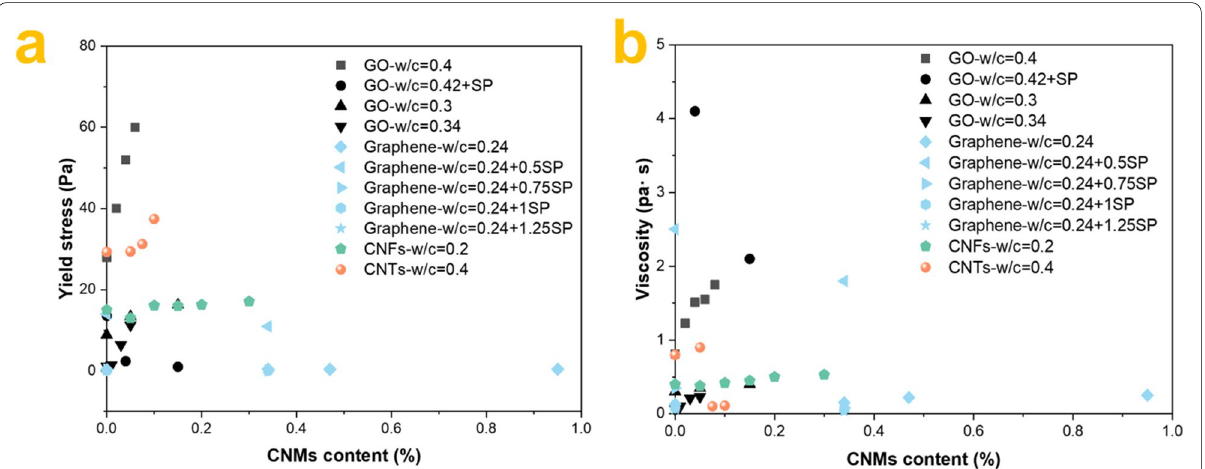
Fig. 7 Influence of CNMs on the rheology properties of fresh mixtures: a yield stress and b viscosity [22, 29, 97, 128–134]. SP is standing for polycarboxylate